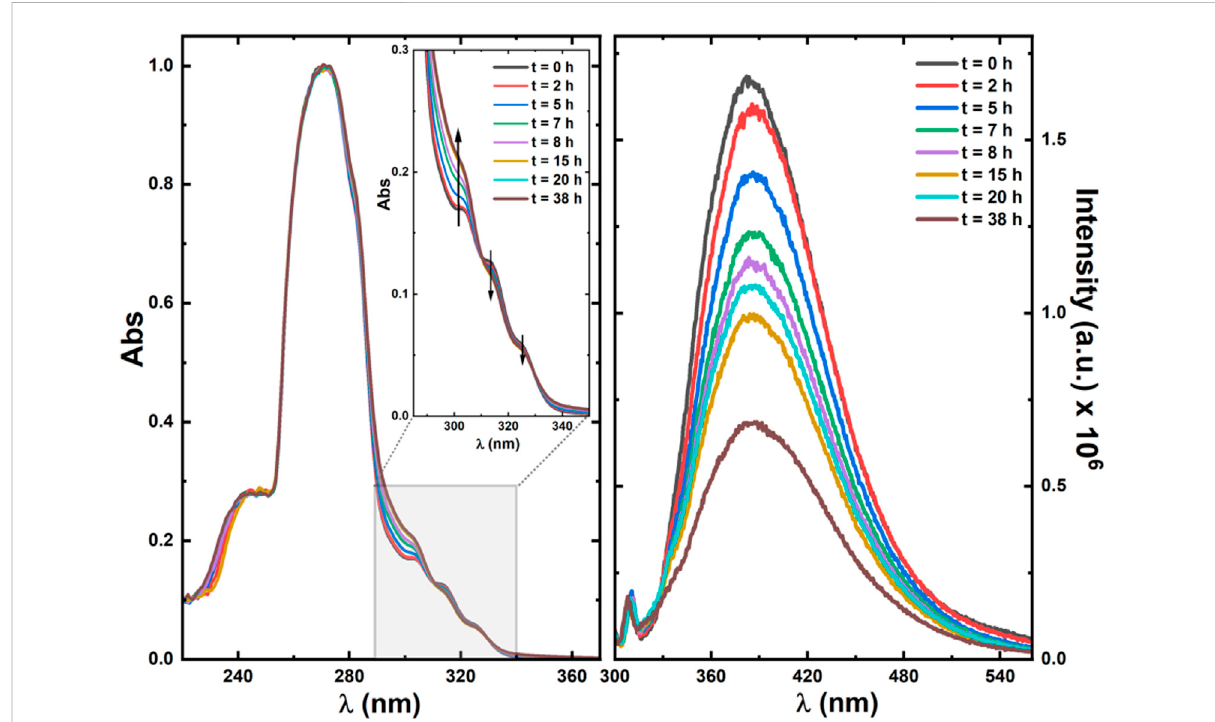
FIGURE 9 Normalized absorption (left) and fl uorescence emission (right) spectra of ketodiacid 3 in DMSO-d 6 solution with different irradiation times. In the absorption spectra the shape of the spectra for wavelength values below 260 nm mirrors the solvent ’ s cut-off, and the vertical arrows indicate the increase (~304 nm) and decrease (~314 nm and ~327 nm) of the absorption